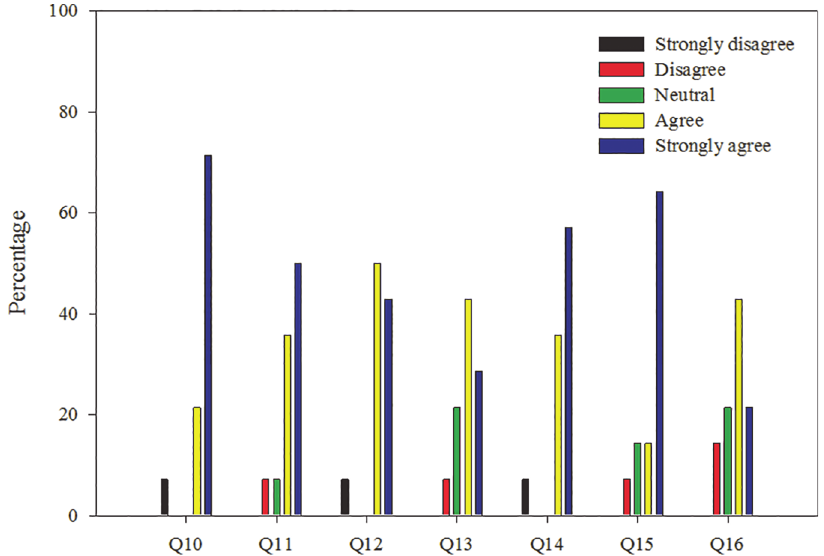
Fig 3. Participant written evaluation responses focused on the workshop material. Q10: The workshop increased my knowledge of molecular techniques; Q11: The workshop was well paced within the allotted amount of time; Q12: The workshop goals were clearly stated; Q13: The workshop protocols were clear and useful; Q14: Questions and concerns were addressed appropriately; Q15: The presenters provided for a variety of learning styles; Q16: I am comfortable teaching the material presented in this